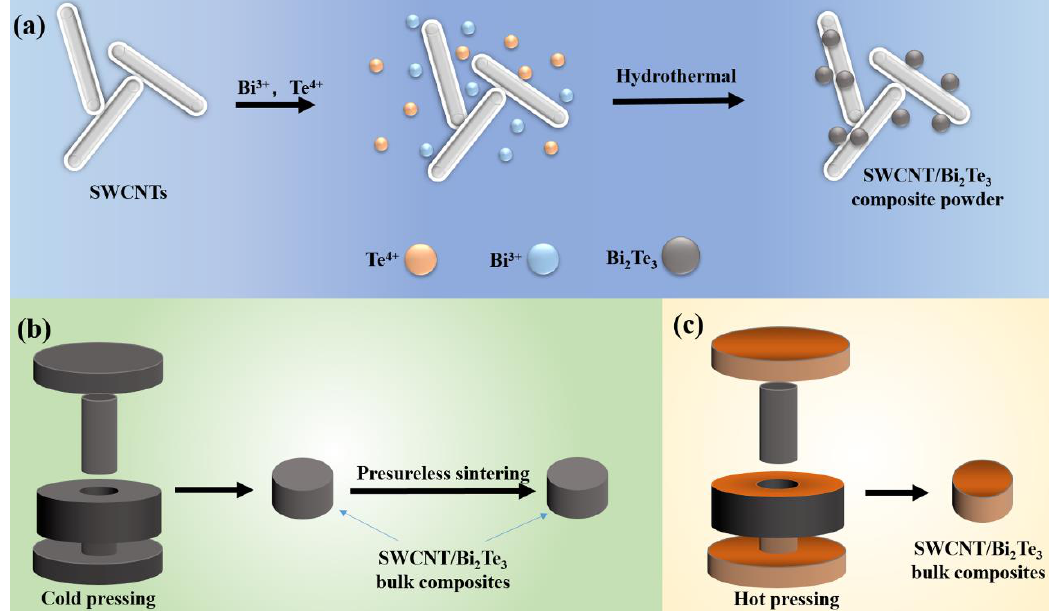
Figure 1. ( a ) The preparation procedures of the single-walled carbon nanotube (SWCNT)/Bi 2 Te 3 composite powders, ( b ) bulk composites (prepared by a cold-pressing combing pressureless sintering process), and ( c ) bulk composites (prepared by a hot-pressing